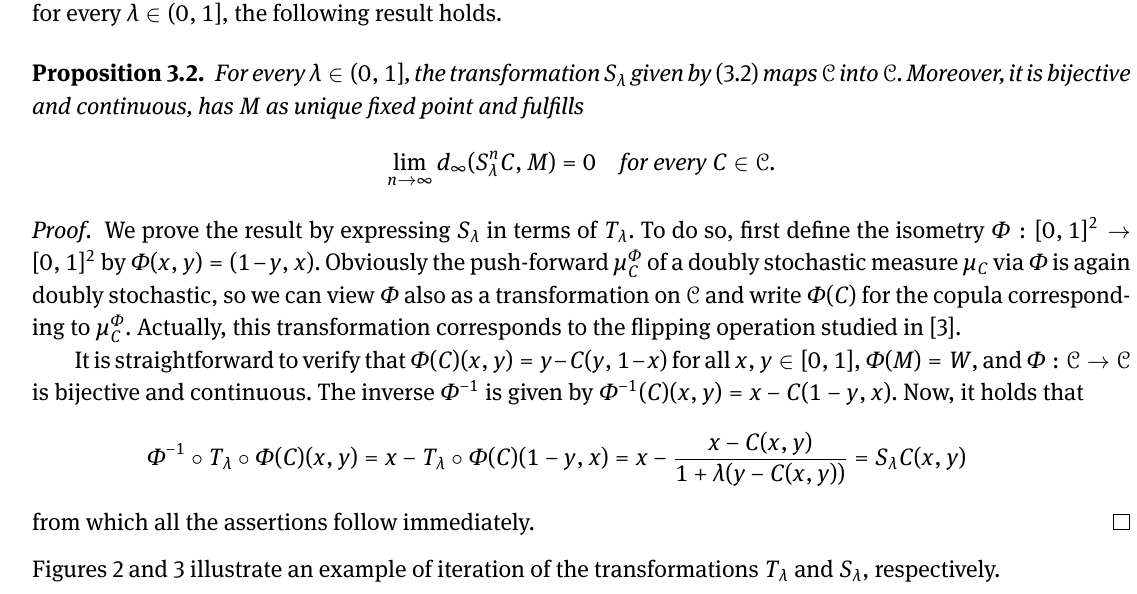
( M ) for n ∈ { 0, 1, 5, 20 } , whereby λ = 1/2 λ